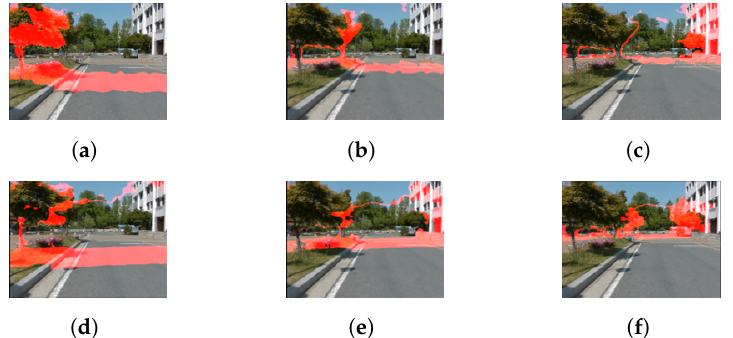
Figure 10. Depth estimation results using CNU dataset. ( a ) Stereo depth 5 to 10 m, ( b ) stereo depth 10 to 20 m, ( c ) stereo depth 20 to 40 m, ( d ) depth fusion (5 to 10 m), ( e ) depth fusion (10 to 20 m), and ( f ) depth fusion (20 to 40